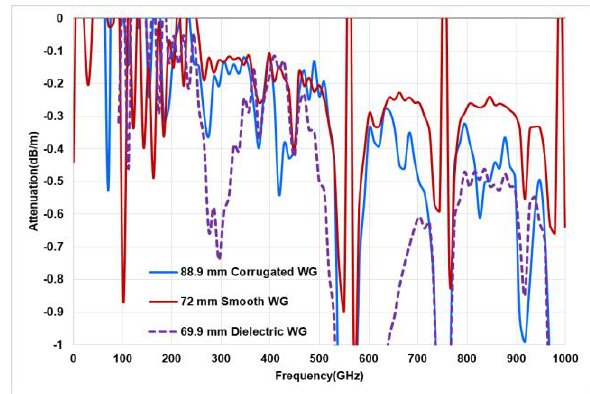
Fig. 7: Comparison of per meter transmission attenuation for various TLs